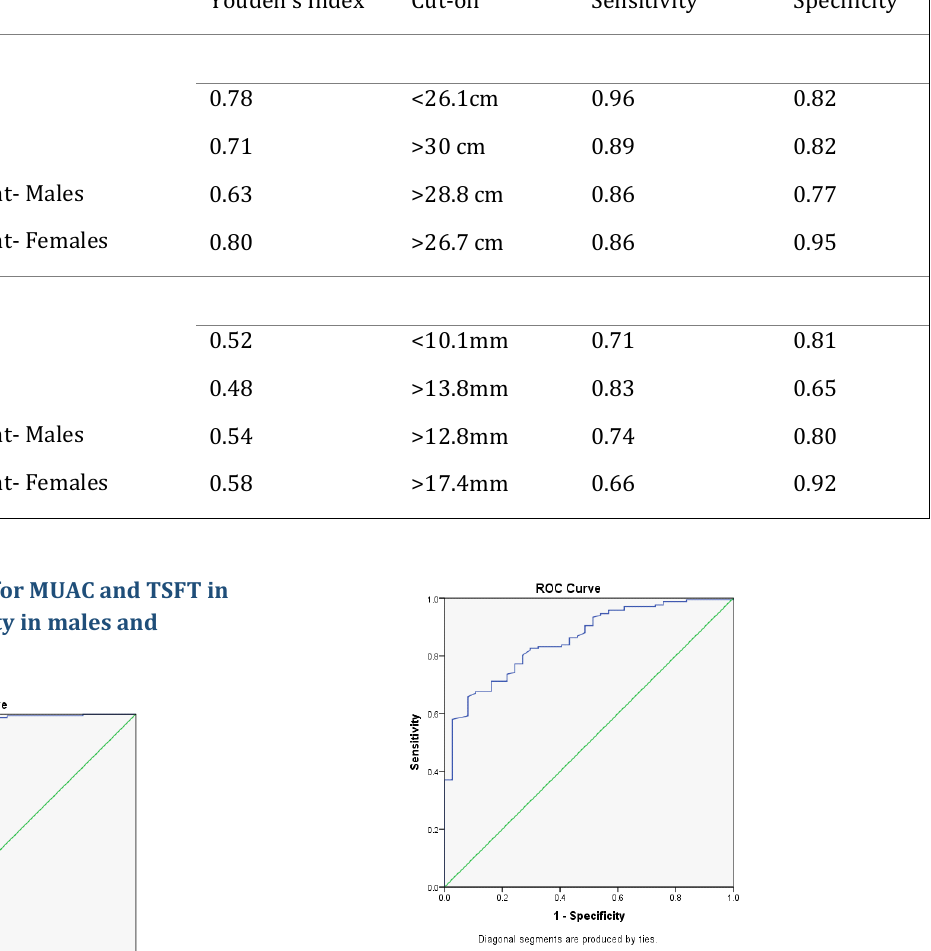
Table 3: Sensitivity and Specificity of MUAC and TSFT in detecting underweight and obese Test